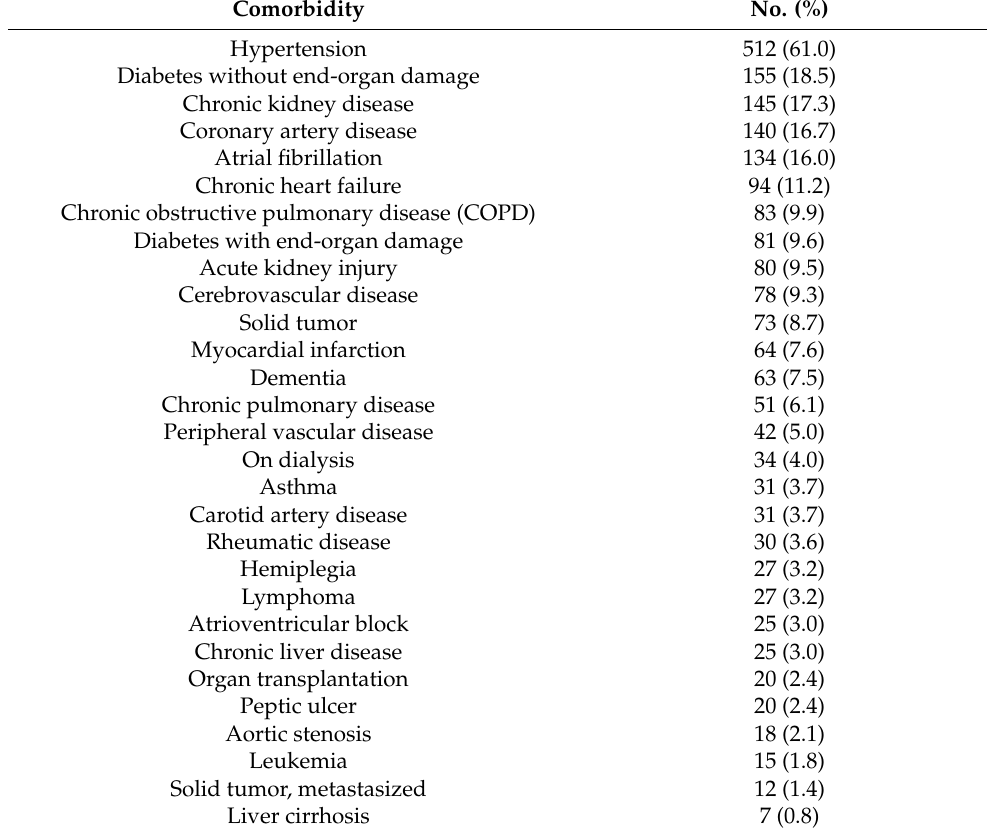
Table 1. Comorbidities of the study cohort ( n =